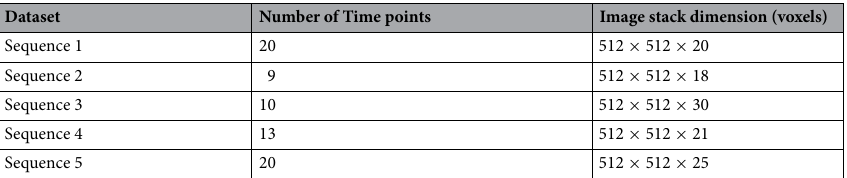
Table 2. Single layer pavement cell dataset 7 . It consists of a long-term time-lapse from A. thaliana’s leaf epidermal tissue that spans over a 12 h period with a xy-resolution of 0.212 μm and 0.5 μm thick optical sections. The time step is 2 h for sequence#2 and is one hour for all other sequences. Anticlinal cell walls are partially annotated for all sequences. In addition to that, cells are partially annotated for sequence 5.